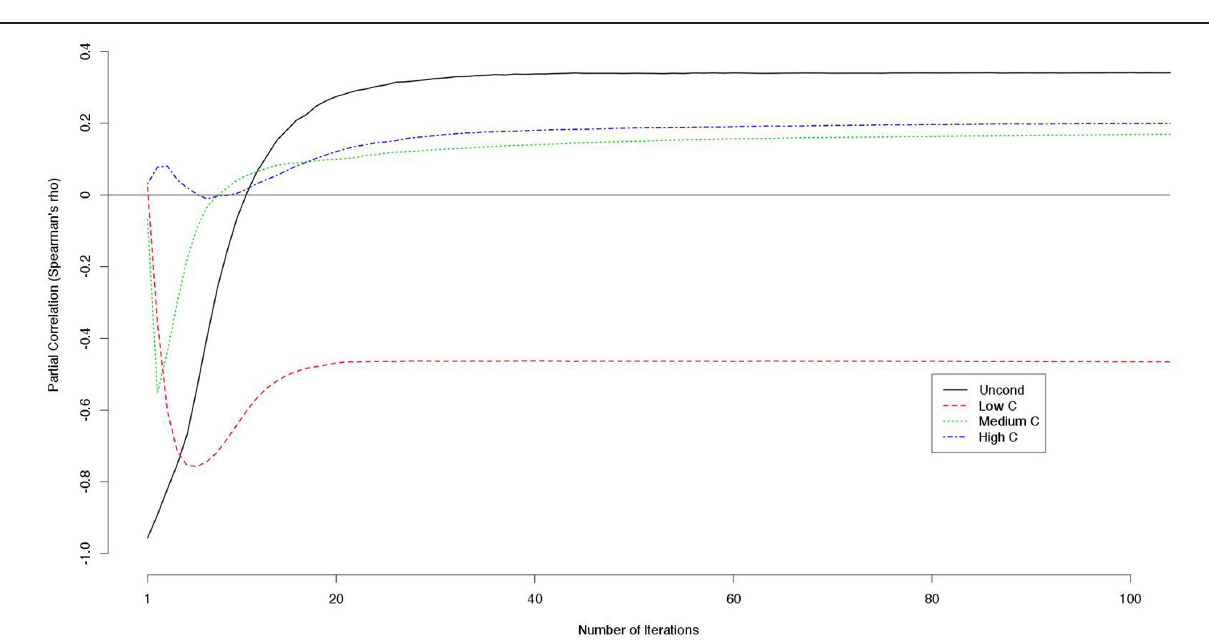
(e.g., a UC2 score) and the payoff controlling for the other deci- sion scores (e.g., LC2, MC2, and HC2 scores). The LC2 scores constantly correlated negatively with the outcome while the other scores correlated positively with larger numbers of iterations ( Figure 2